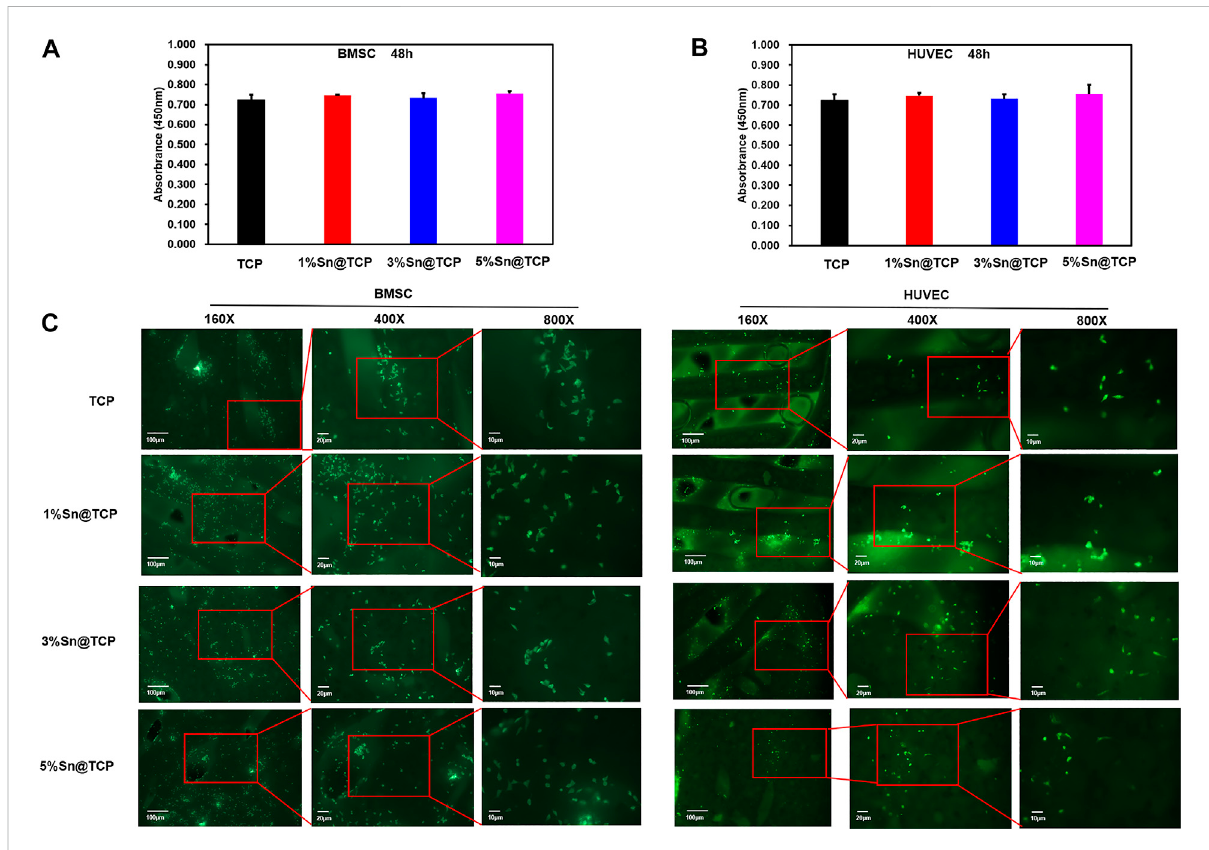
FIGURE 5 Cell growth on Sn@TCP scaffolds. (A) The viability of BMSC cells growth on scaffolds for 48 h. (B) The viability of HUVEC cells growth on scaffolds for 48 h. (C) The fl uorescence staining of BMSC and HUVEC cells growth on scaffolds for 48 h (Magni fi cation from ×160 to 800X, bar = 100 μ m, 20 μ m, and 10 μ